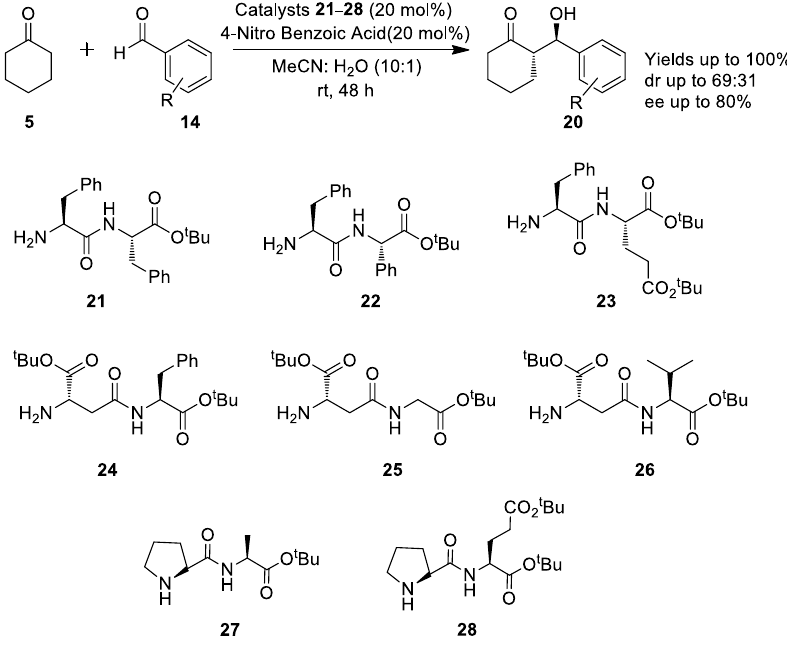
Catalysts 2022 , 12 , Scheme 11. Asymmetric aldol reaction of linear ketones with aromatic aldehydes catalyzed amino amides.